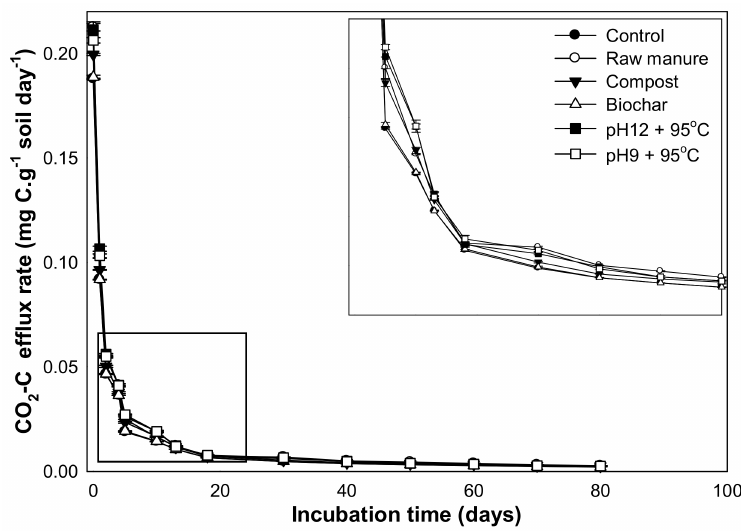
Figure 11. CO 2 efflux rate (mg C/g soil/day) affected by different organic amendments derived from cow manure at different incubation times (marked box is magnified to show the trend).